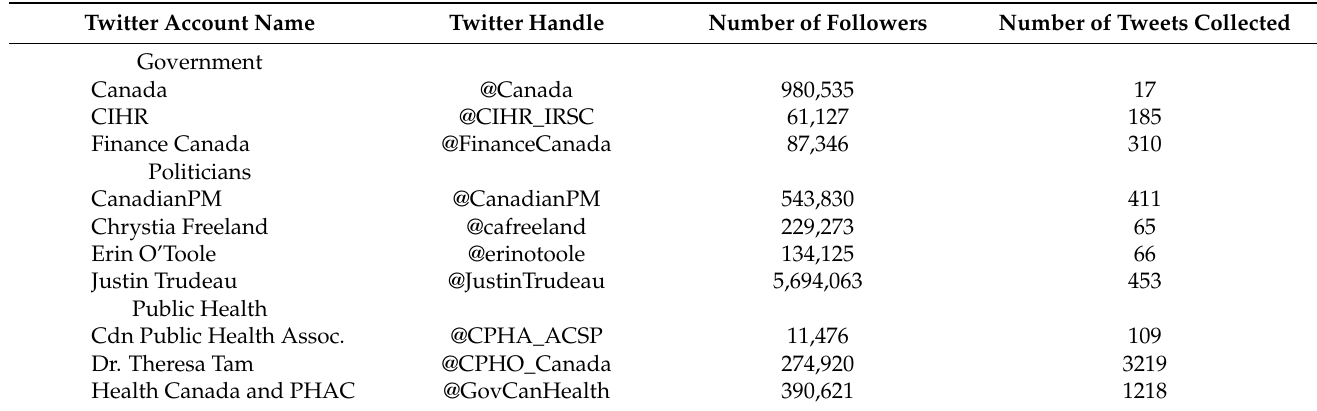
Table 2. Twitter account name, Twitter handle, number of followers as of 9 August 2021, and the number of tweets that were